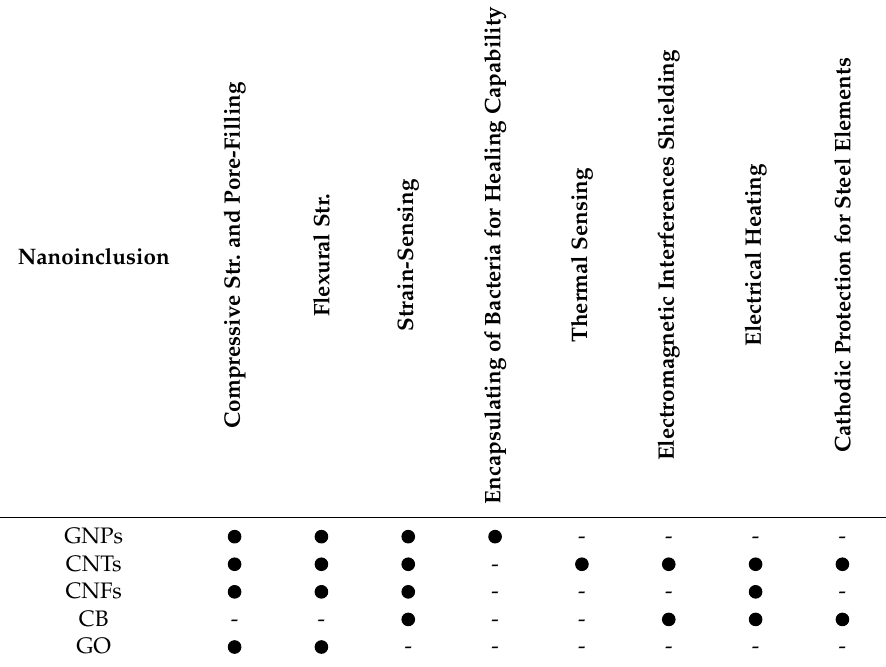
Table 5. Most remarkable properties enhanced or provided by carbon-based